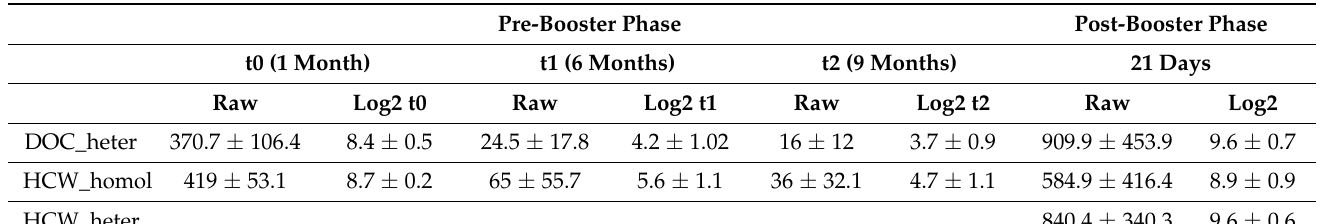
Table 2. Raw and transformed Log2 values of antibody responses in DOC and HCW